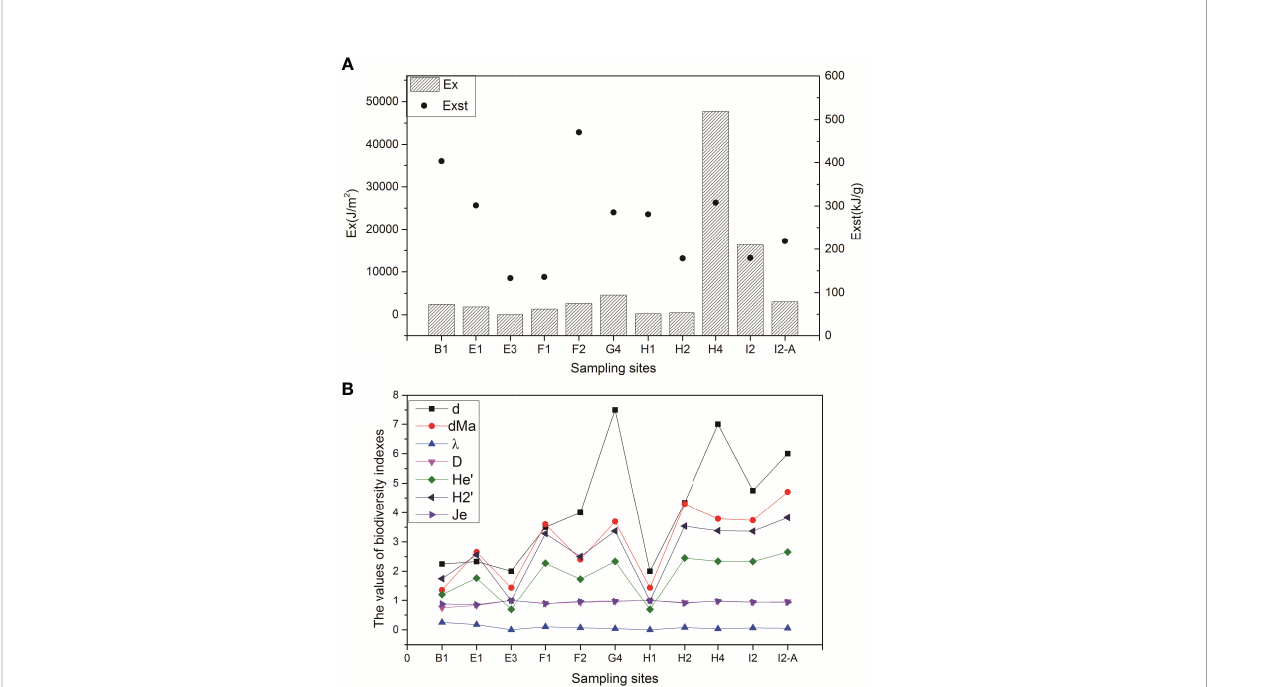
FIGURE 6 (A) The values of the Ex and Exst indicators at the sampling sites; (B) the values of the biodiversity indicators at the sampling sites in the